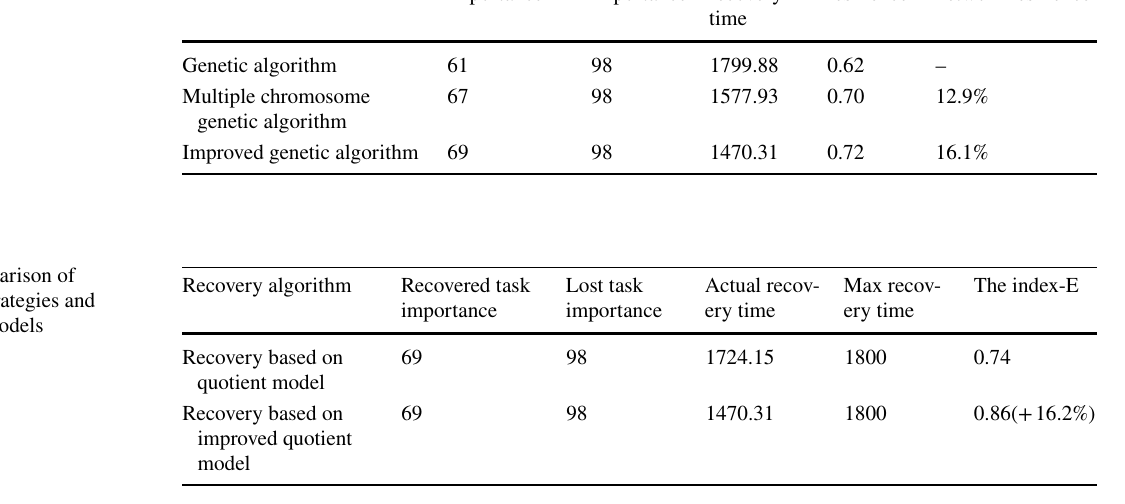
Table 10 Comparison of network resilience on improved quotient model